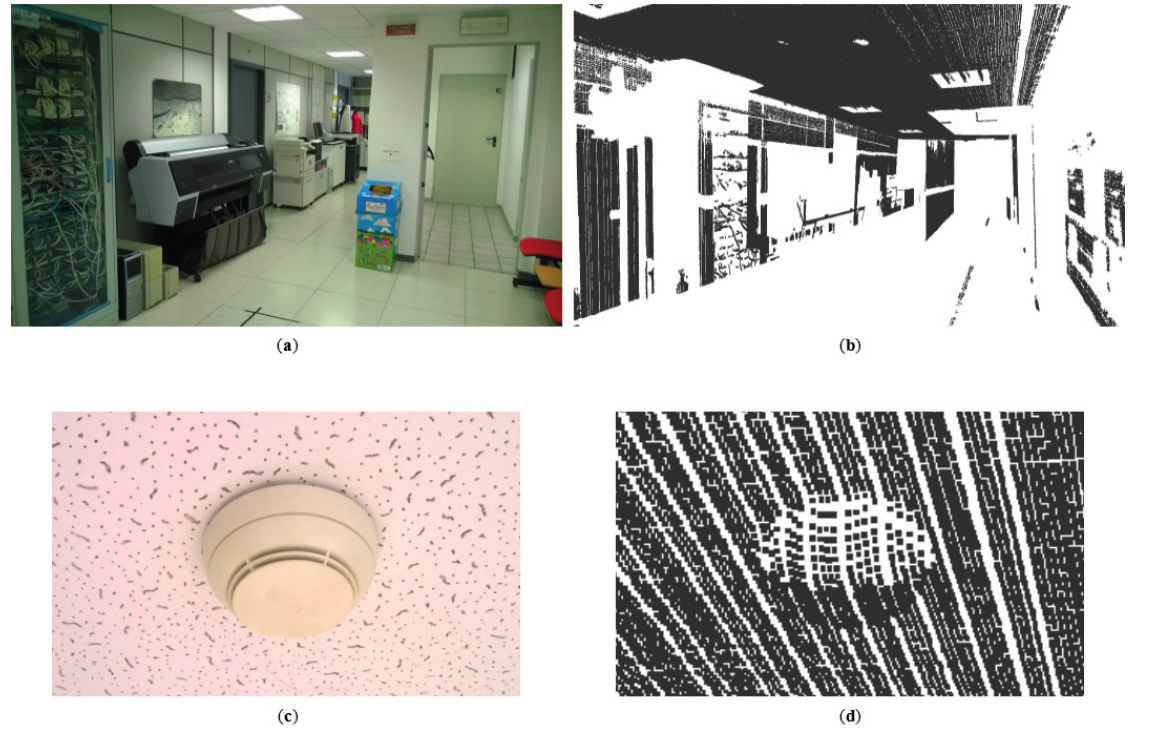
Figure 14. ( a ) Acquired corridor and ( b ) corresponding 3D reconstruction; ( c ) picture